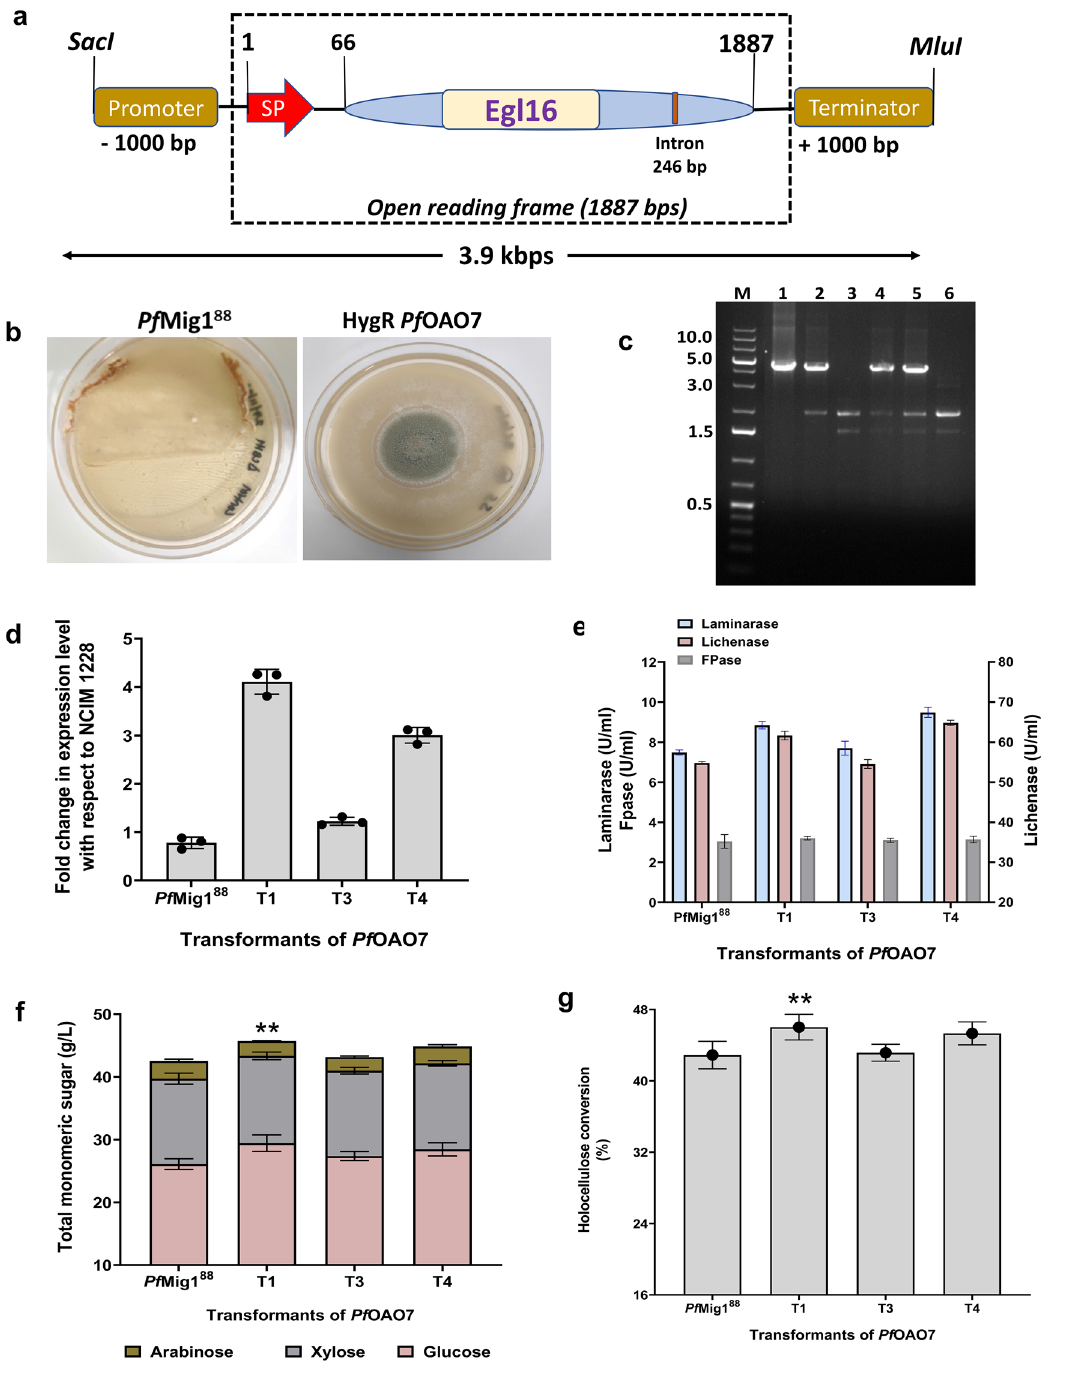
Figure 4. Construction of the Pf Egl16 expression cassette and its overexpression in Pf Mig1 88 . ( a ) Schematic diagram showing the assembly of the Pf Egl16 cassette from the P. funiculosum NCIM1228 genome. ( b ) Transformants of pOAO9 after AMTM transformation in Pf Mig1 88 . Transformants were selected on 100 µg/ml hygromycin. ( c ) Determination of Pf Egl16 integration in the genome of Pf Mig1 88 transformants by PCR using the primers PgpdA-F and TrpC-R. The expected size is 5 kbp, corresponding to a fragment spanning the region of gpdA promoter and TrpC on the expression cassette. Lane M is DNA molecular mass marker; lane (1) is the pOAO9 plasmid which served as a positive control while lanes 2–5 are the transformants of Pf OAO7. Lane (6) is the gDNA of Pf Mig1 88 which was the negative control. ( d ) The transcriptional expression of endoglucanase in NCIM1228, Pf Mig1 88 , and all the three positive strains of Pf OAO7 was measured by quantitative real-time PCR after growing the strains for 60 h in the presence of Avicel and SCB. The expression levels were normalized to those in NCIM1228 and plotted. ( e ) The lichenase, laminarase and FPase activities in the fermentation broth of Pf Mig1 88 and three transformants of Pf OAO7. ( f ) Saccharification performance of Pf OAO7 secretomes on SCB. Total sugar released from hydrolysis of SCB by secretomes of Pf Mig1 88 and three transformants of Pf OAO7. ( g ) Percentage holocellulose conversion measured at 72 h saccharification period. ** shows the significant difference at α = 0.05 using Tukey’s multiple comparison